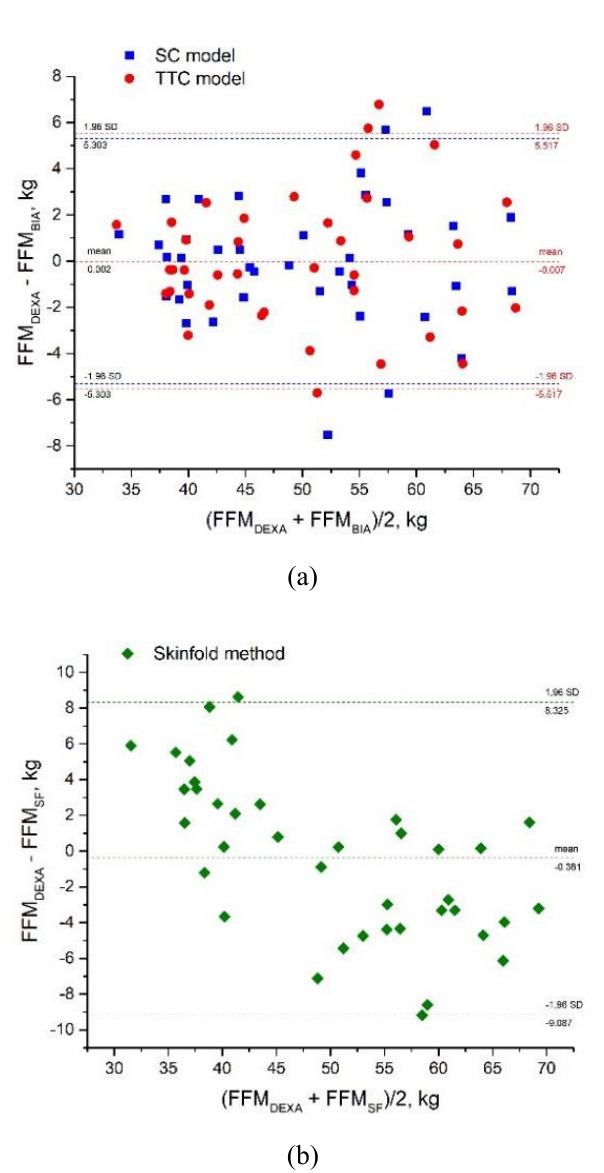
Fig.6: Bland-Altman plots for WIM FFM estimate validation: (a) Single cylinder (SC) model: confidence intervals for the mean bias: (-0.874, 0.879) kg, for upper LOA: (4.380, 6.937) kg, for lower LOA: (-6.932, -4.375) kg; TTC model: for mean bias: (-0.920, 0.905) kg, for upper LOA: (4.547, 7.208) kg, for lower LOA: (-7.223, -4.562) kg. (b) Skinfold thickness calculations: confidence intervals for the mean bias: (-1.792, 0.955) kg, for upper LOA: (6.653, 10.651) kg, for lower LOA: (-11.488, -7.4918) kg.